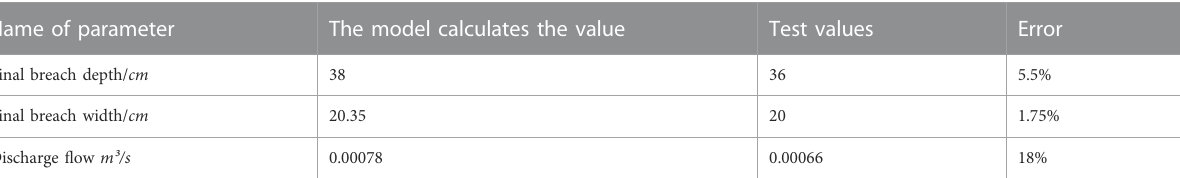
TABLE 4 Comparison of calculated